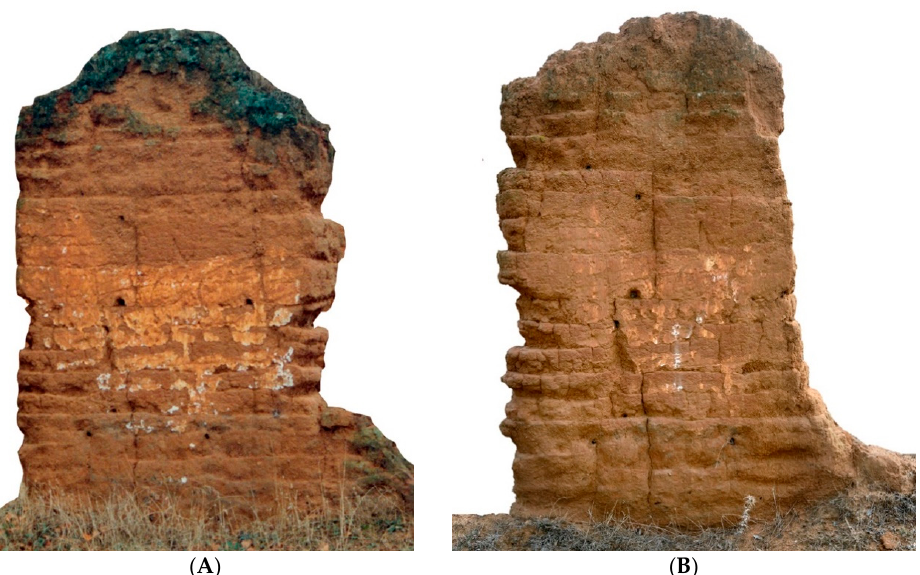
Figure 4. The southern face of the southeastern wall block at Jugiong (NSW). ( A ) Appearance on 15 February 1993; ( B ) appearance on 2 April 2015. Reprinted from Ref. [9] . February 1993; ( B ) appearance on 2 April 2015. Reprinted from Ref.